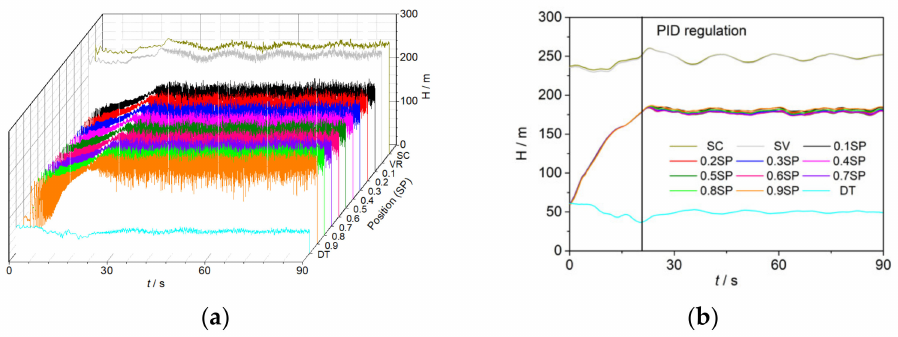
Figure 19. Dynamic pressure pulsations during start-up in Case1. ( a ) Original data; ( b ) The low-pass filtered